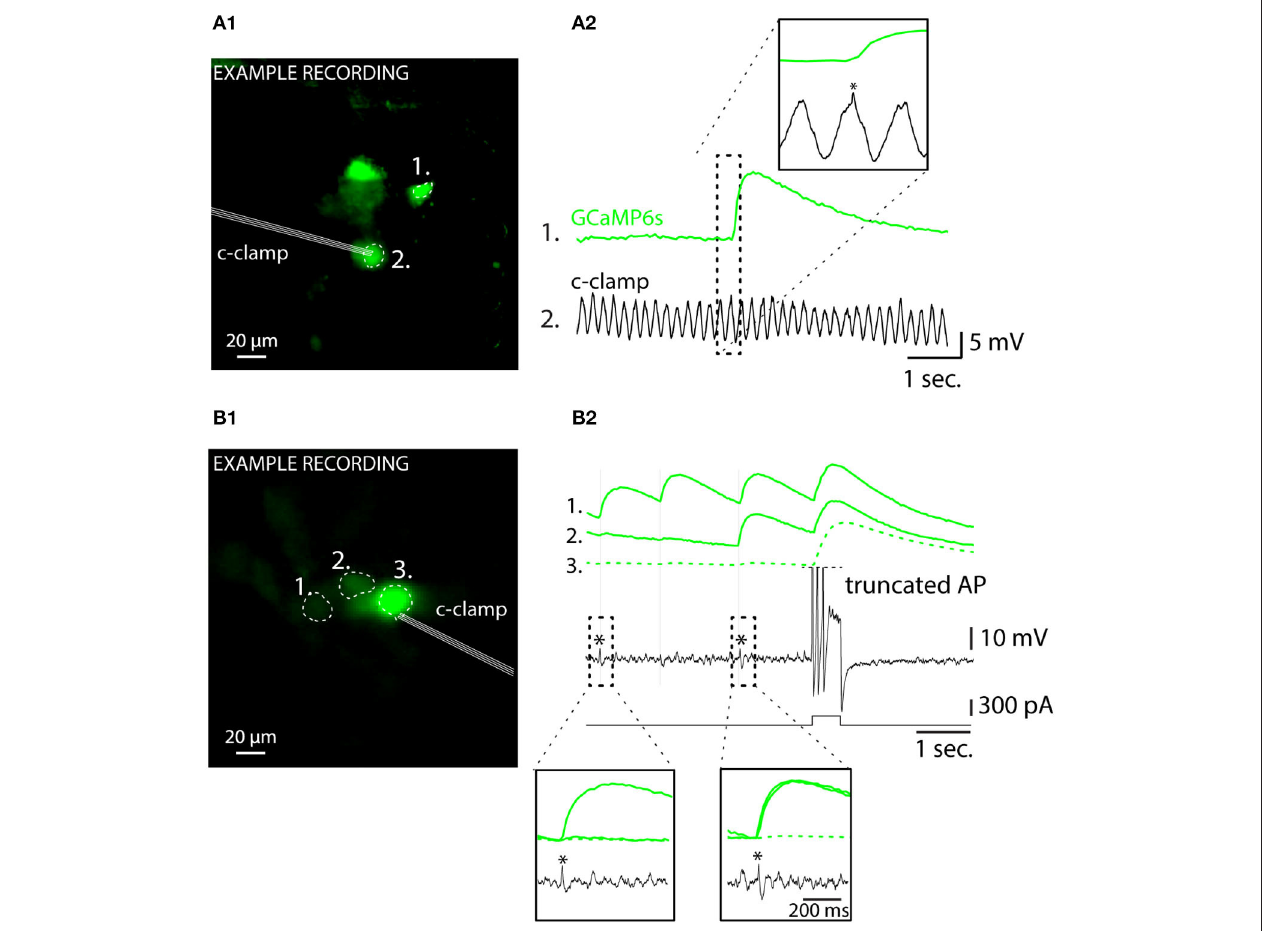
FIGURE 7 | Somatic calcium events are only generated by action potentials occurring in the recorded cells regardless of oscillatory status. (A) Simultaneous current-clamp and GCaMP6s imaging shows that a spike in a neighboring IO neuron (A1) is reflected as an electrophysiological “spikelet” in the oscillating cell labeled with an asterisk. The image in (A1) is a standard deviation time series projection of fluorescence time-series recording. Note that the image brightness is adjusted for viewing and should not be considered as representative of the dynamic range during live imaging. Only cells that spiked during the recording are visible. (A2) shows time-aligned fluorescence (top) and V m (bottom) traces, and the neighbor-spike-related spikelet in patched cell is indicated with an asterisk in the inset. (B) Another example of a simultaneous GCaMP6s and current-clamp recording from 3 IO neurons demonstrating presence of electrophysiological “spikelets” in a patched cell [labeled with “*” in (B1) ] linked with neighboring cell calcium events. There are three spikelets in the recording, indicated by thin vertical lines, and two of them are enlarged in insets. Current-injection-evoked spiking in the patched cell results in calcium spikes in the neighbor cells, indicative of gap junction